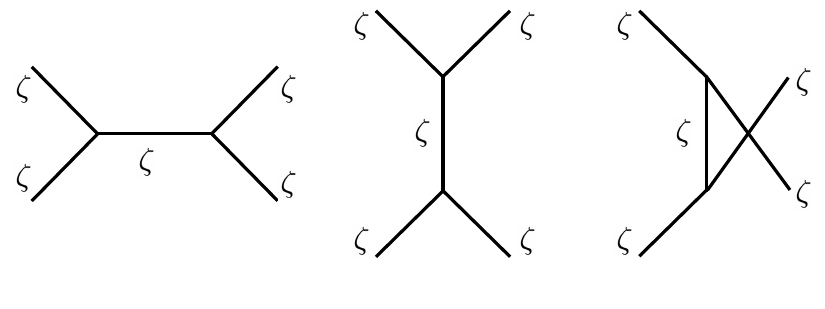
Figure 2 . Purely scalar tree-level diagrams: case (a) .